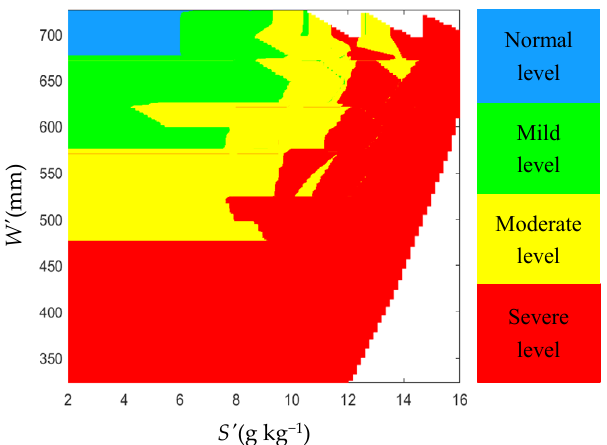
Figure 7. Relationship between relative yield decrease and S ’ and W ’.